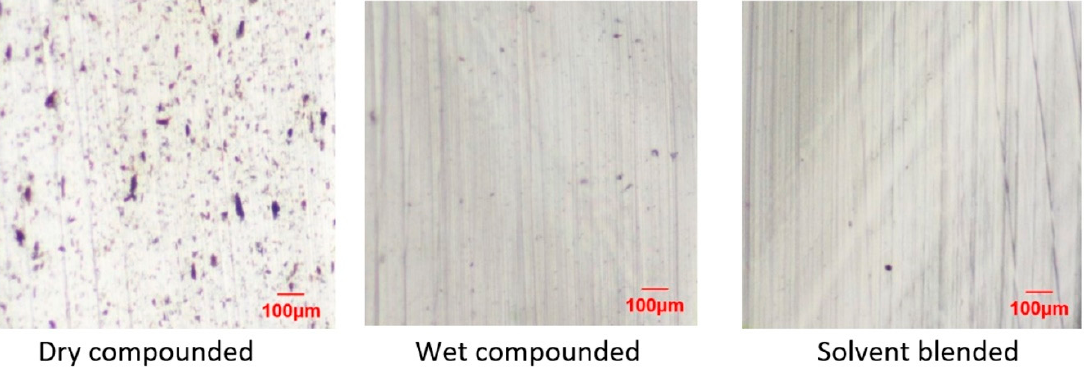
Figure 7. Microscope images of sections of PA6-CNC composites prepared by dry compounding of freeze-dried CNCs, wet compounding of CNC dispersion, and solvent blending in formic acid [8]. All composites contain 5% CNC by weight.